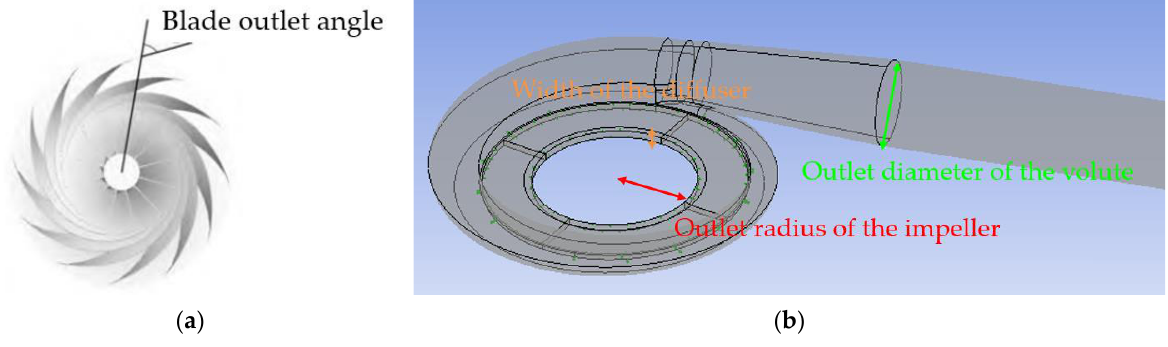
Figure 17. Schematic of the optimized parameters. ( a ) Blade outlet angle. ( b ) Other optimized pa-